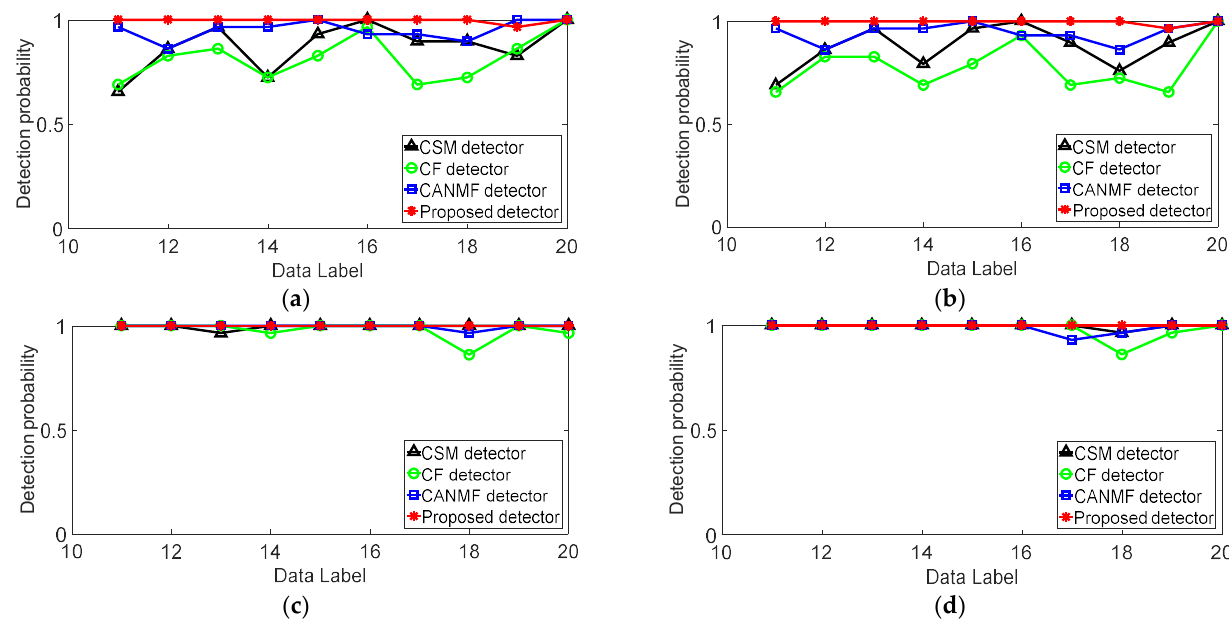
Figure 14. Target detection results on IPIX-1998 dataset. ( a ) HH. ( b ) HV. ( c ) VH. ( d ) VV.